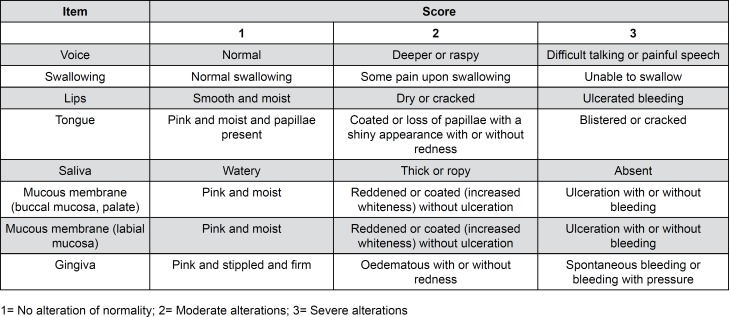
Modified Oral Assessment Guide to monitor the oral health of patients undergoing chemotherapy